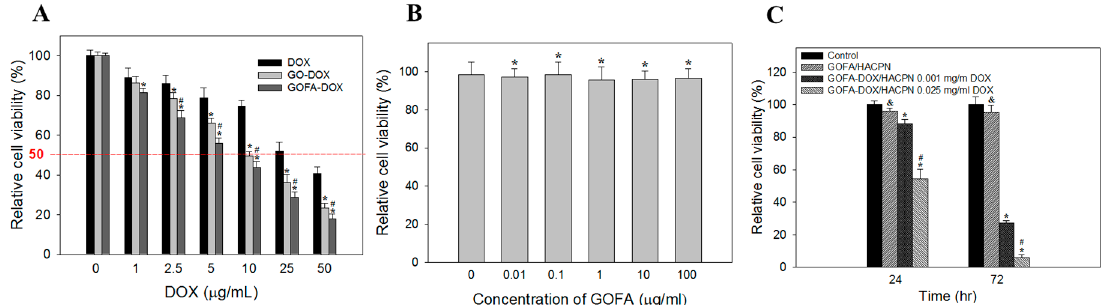
Figure 7. ( A ) Cytotoxicity of free DOX, GO-DOX and GOFA-DOX against MCF-7 cells. The cells were